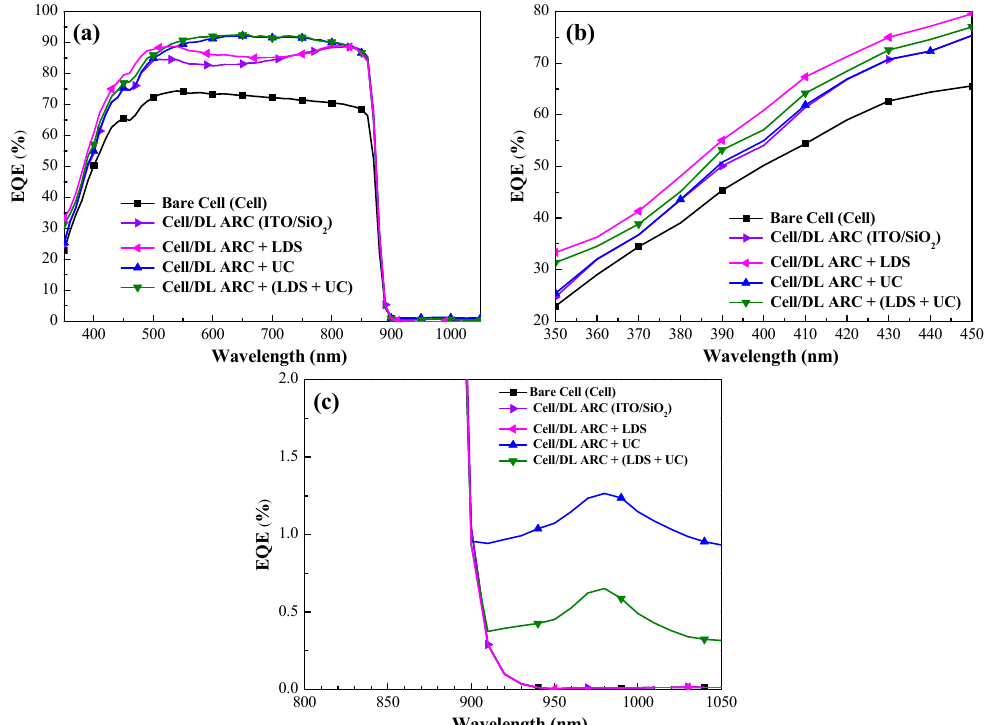
Figure 12. ( a ) EQE response of bare-type GaAs single-junction solar cell (cell), cell / DL-ARC (ITO / SiO 2 ), cell / DL-ARC + LDS, cell / DL-ARC + UC, and cell / DL-ARC + (LDS + UC); ( b ) EQE response due to LDS effect at short wavelength region; and ( c ) EQE response due to UC effect at long wavelength region.